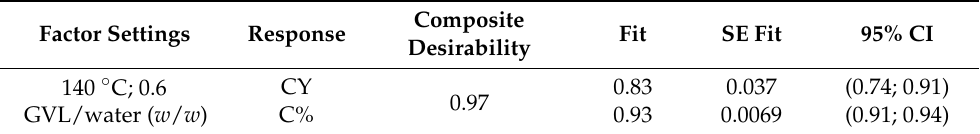
Table 4. Factor settings for the optimal solution and composite desirability. The goals was to maximize CY and C%.